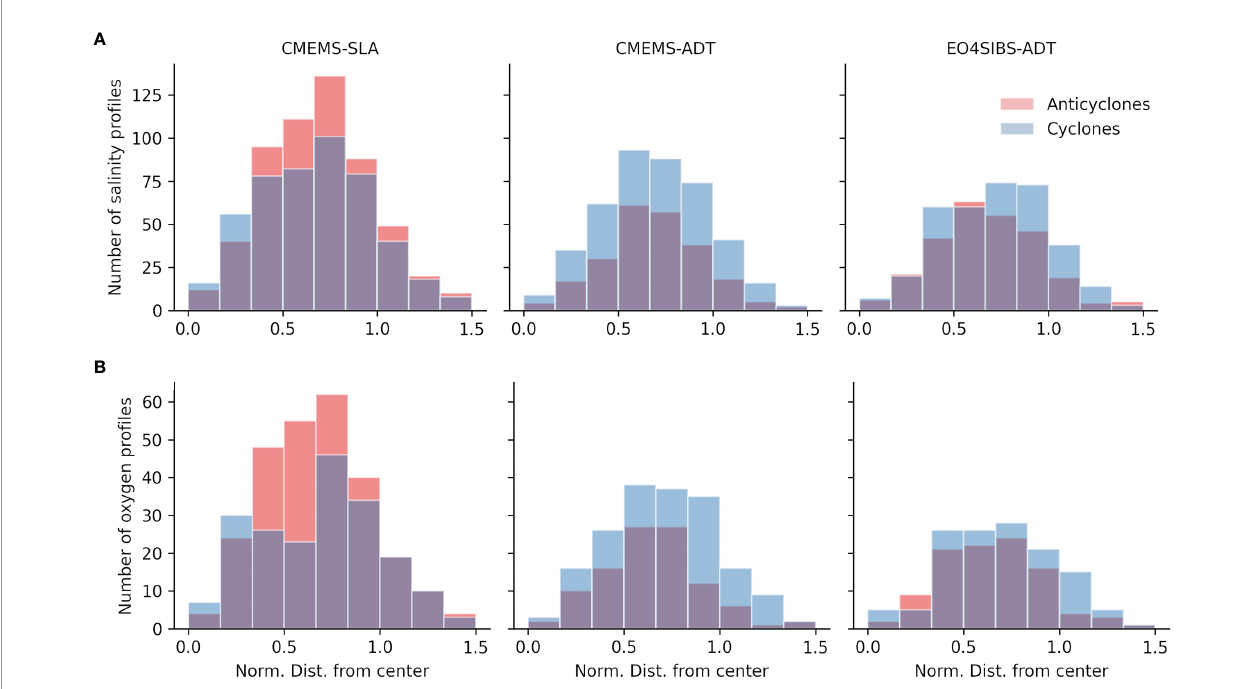
FIGURE 9 | Number of exploitable Argo pro fi les for different relative distances to an eddy center (ie. the distance normalized by the effective eddy radius). (A) Argo, (B)